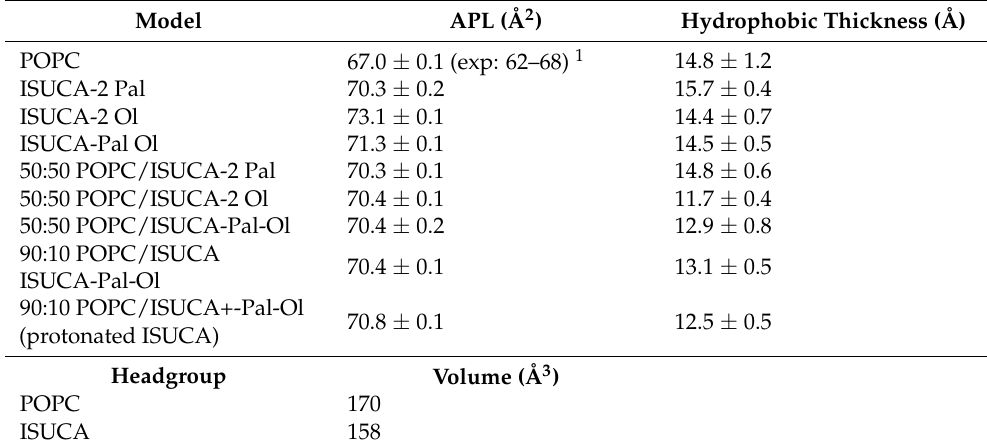
Table 1. APL and hydrophobic thickness of bilayers. The calculated volumes of the lipid headgroups are also shown in the last two